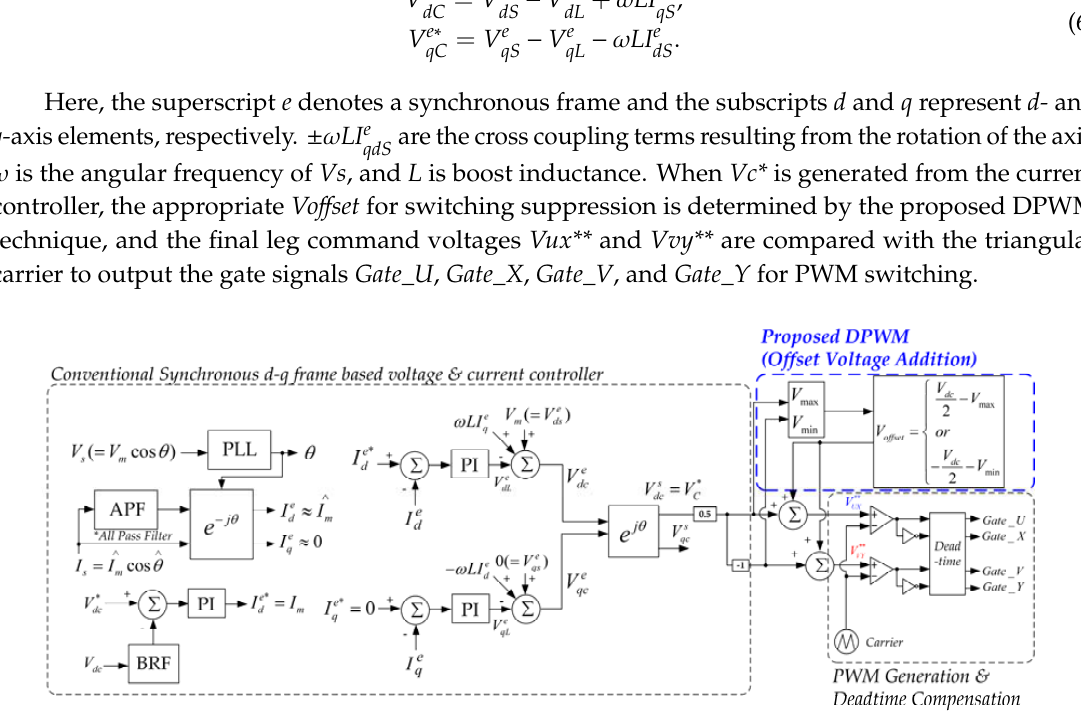
Figure 7. Equivalent circuits for DPWM based single ‐ phase PWM converter during one power cycle when adopting UCM ( a – d ), and LCM ( e – h ).